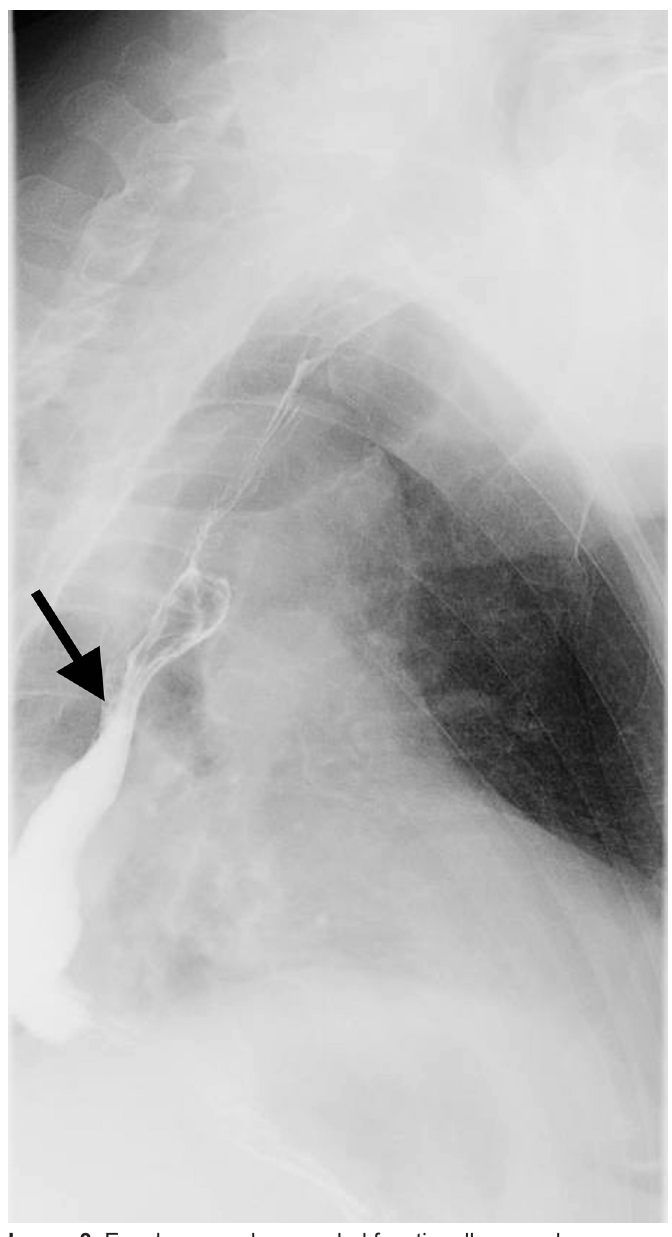
Image 3. Esophagography revealed functionally normal esophagus (arrow).